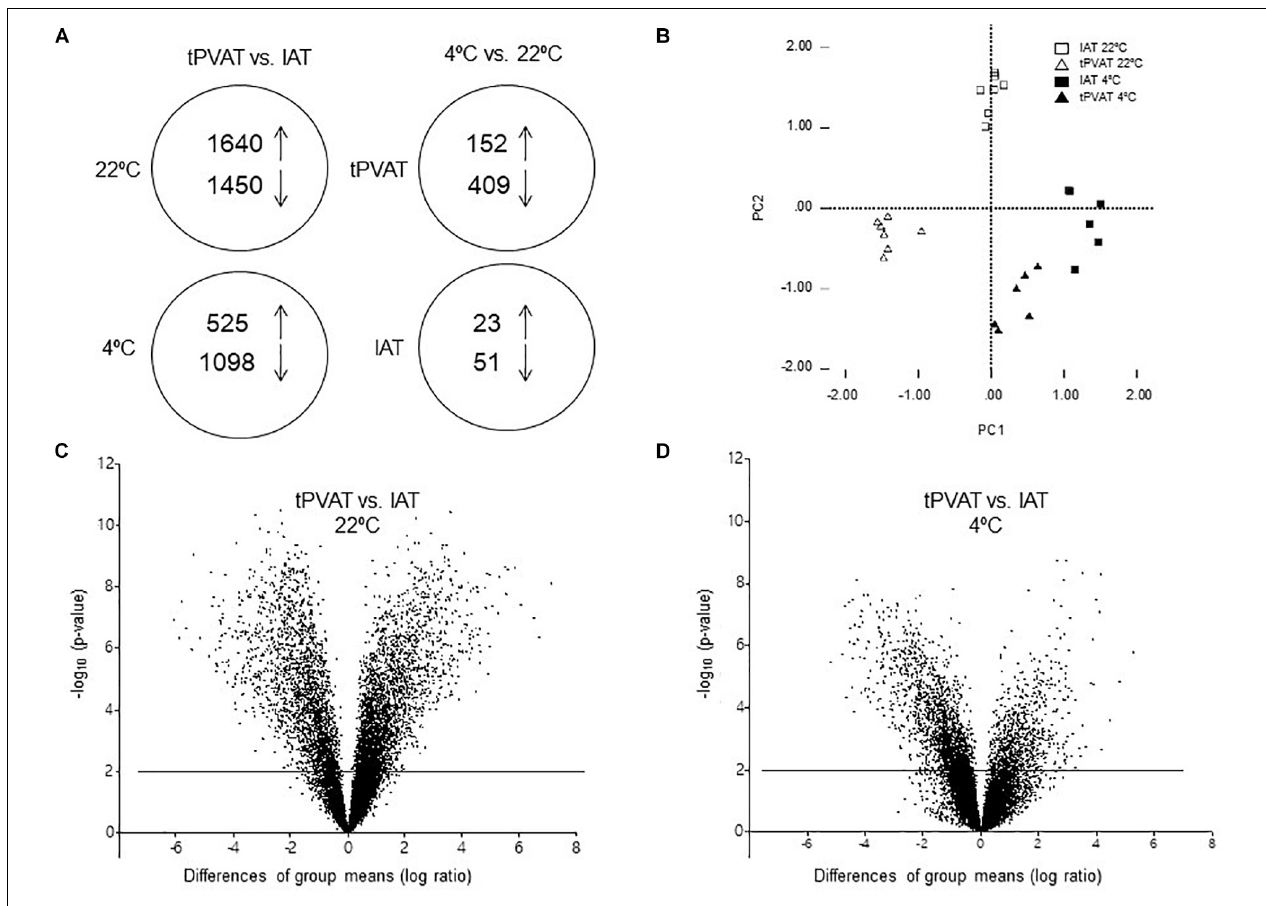
FIGURE 3 | (A) Schematic overview of regulated genes in tPVAT and in IAT in control (22 ◦ C) vs. cold (4 ◦ C) exposed ferrets (Student’s t -test, p -value < 0.01, with an absolute fold change ≥ 2). The arrows show the number of genes up- and down-regulated in each analysis. (B) PCA analysis of gene expression in tPVAT and IAT at 22 and 4 ◦ C of a subset of genes being differentially expressed in tPVAT vs. IAT at control (22 ◦ C) temperature (Student’s t -test, p -value < 0.01, with an absolute fold change ≥ 2). Volcano plot for all expressed probes in control (C) and cold conditions (D) . Minus log10 p -value of all genes are plotted against the differences of group means (log ratio) of each gene, tPVAT vs. IAT. The line indicates the threshold p -value < 0.01. The results represent data from the control ( n = 7) and cold ( n = 6–7)